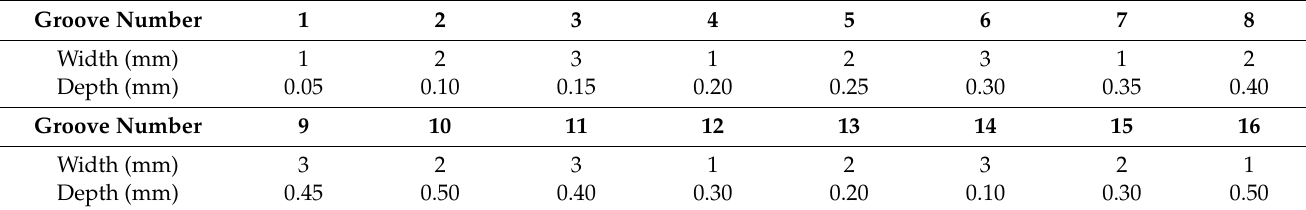
Table 2. Groove parameters in the X-direction (Starting from X = 0).